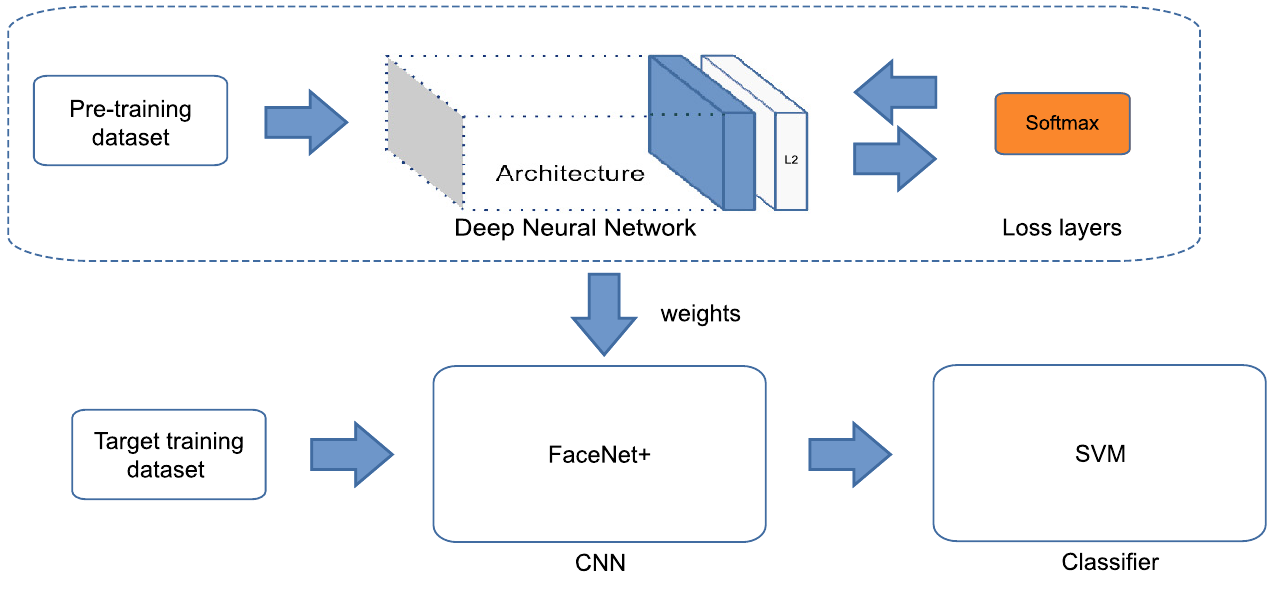
Figure 5. An overview of the proposed FaceNet+SVM framework.